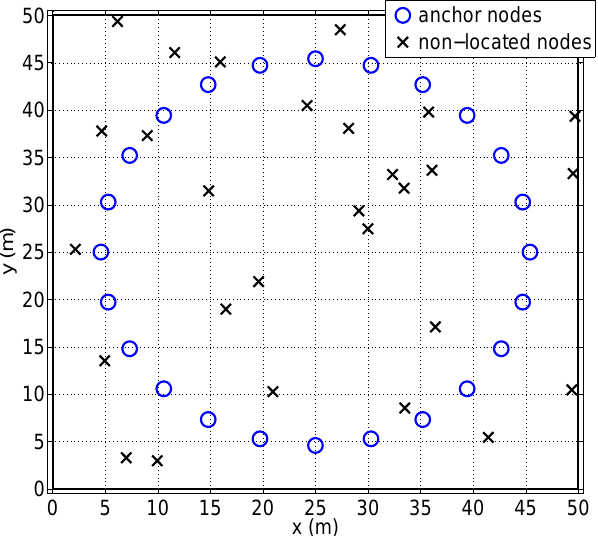
Figure 1. Example of an scenario deployment.